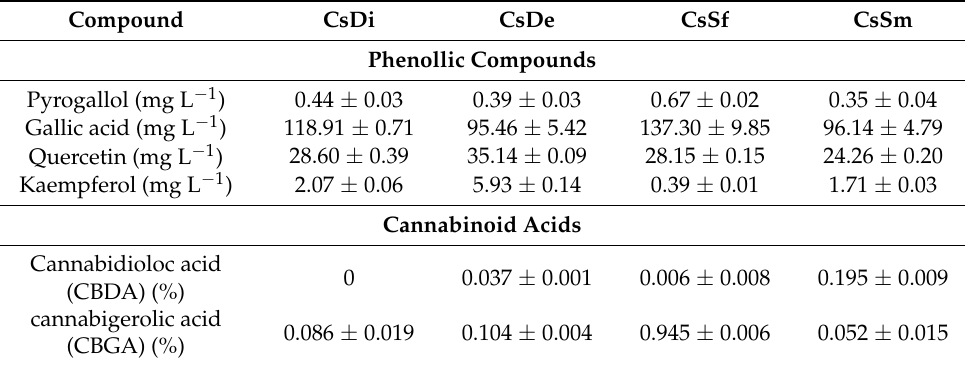
Table 1. The chemical composition of the aqueous extracts determined by UHPLC-DAD-MS.